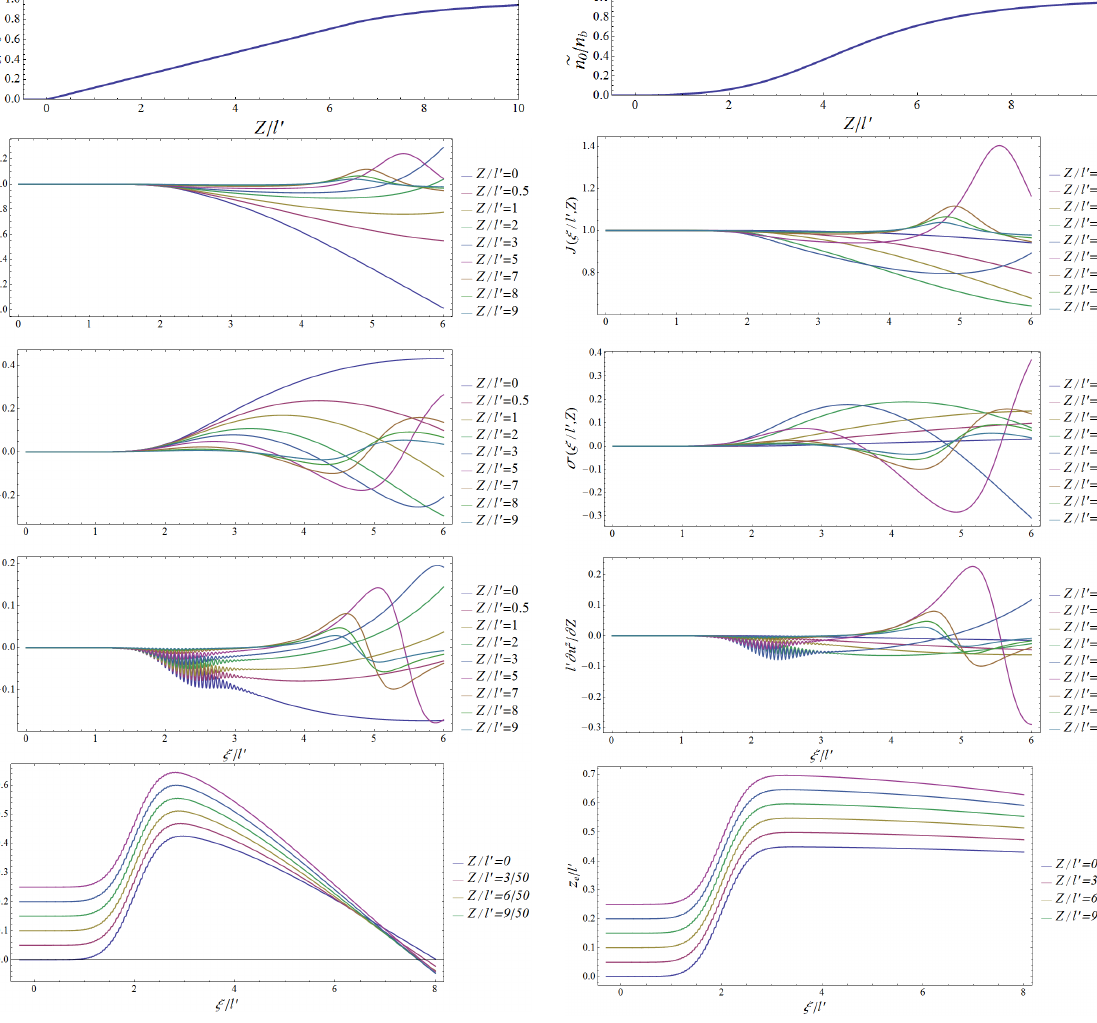
Figure 5. The initial electron densities (3), (4) of Figure 2 (left and right, respectively) with n b = 2 × 10 18 cm − 3 , and below, the corresponding plots of J , σ , l (cid:48) ∂ u z / ∂ z during interaction with the pulse in Figure 1 for a few sample values of Z . As can be seen, J remains positive at least for all ξ ∈ [ 0,2 l ] if the density is of type (4) (which grows as Z 2 for Z ∼ 0), whereas it becomes negative for ξ ∼ 6.5 l (cid:48) and small Z if the density is of type (3) (which grows as Z for Z ∼ 0). Correspondingly, the right-hand worldlines do not intersect, while the left-hand ones do (see the down z e